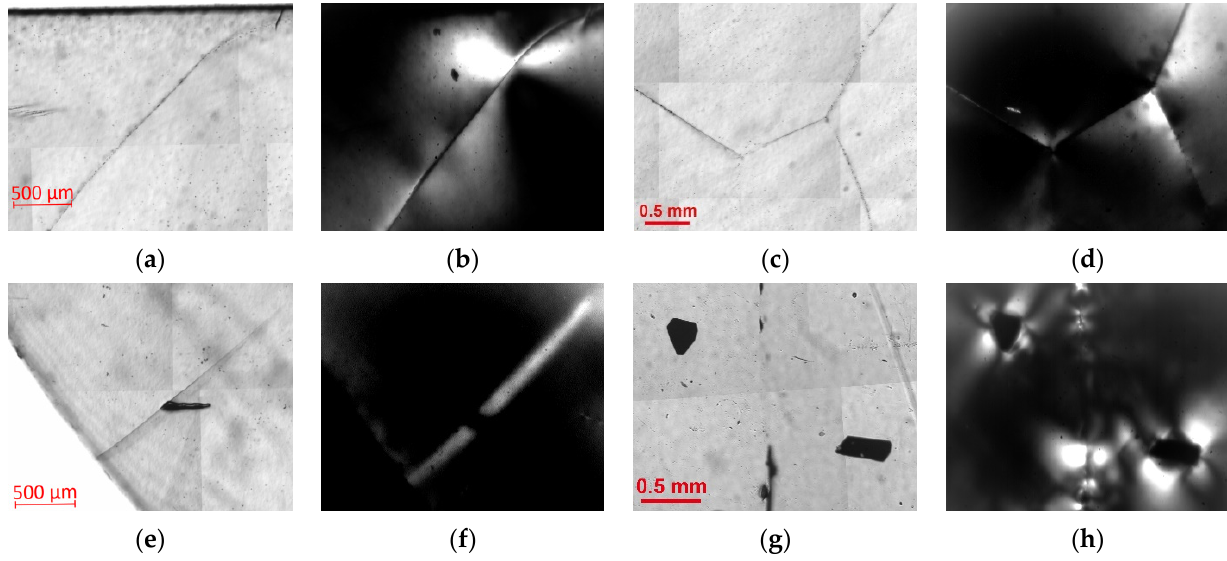
Figure 4. Infrared transmission images and birefringence images showing related local stress fields of typical defects observed in our CZT crystals: grain boundaries ( a – d ); a twin boundary ( e ) and ( f ); Te inclusions ( g ) and ( h ).